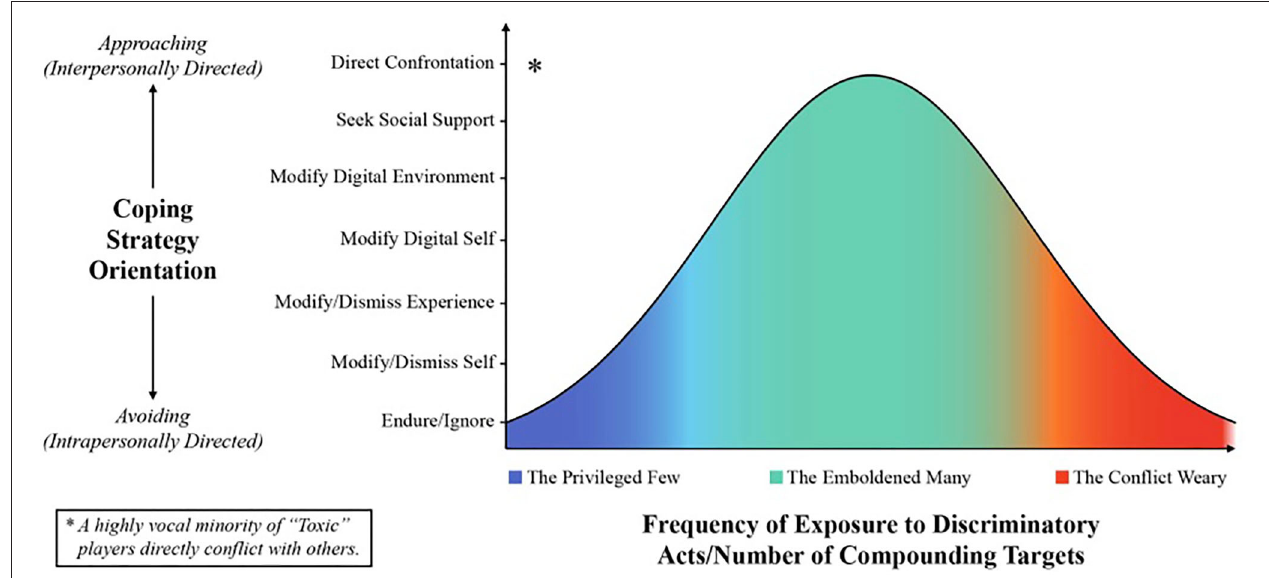
FIGURE 2 | U -shaped curve of the general relationships shared between coping strategy orientation and required effort (on the y-axis) and the number of targets upon which discrimination was experienced (on the x-axis). The outlying highly vocal minority of bigoted players with high approach and high conflict strategies are represented by an